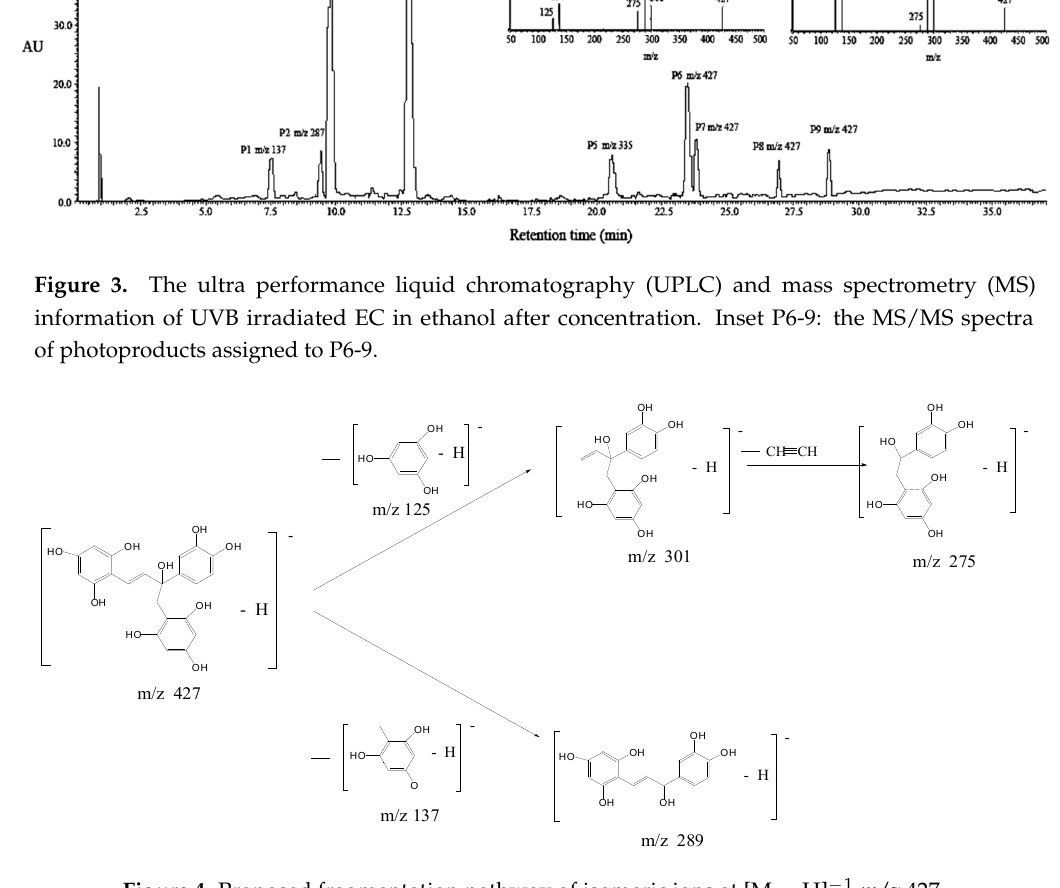
Figure 4. Proposed fragmentation pathway of isomeric ions at [M − H] − 1 m / z 427.